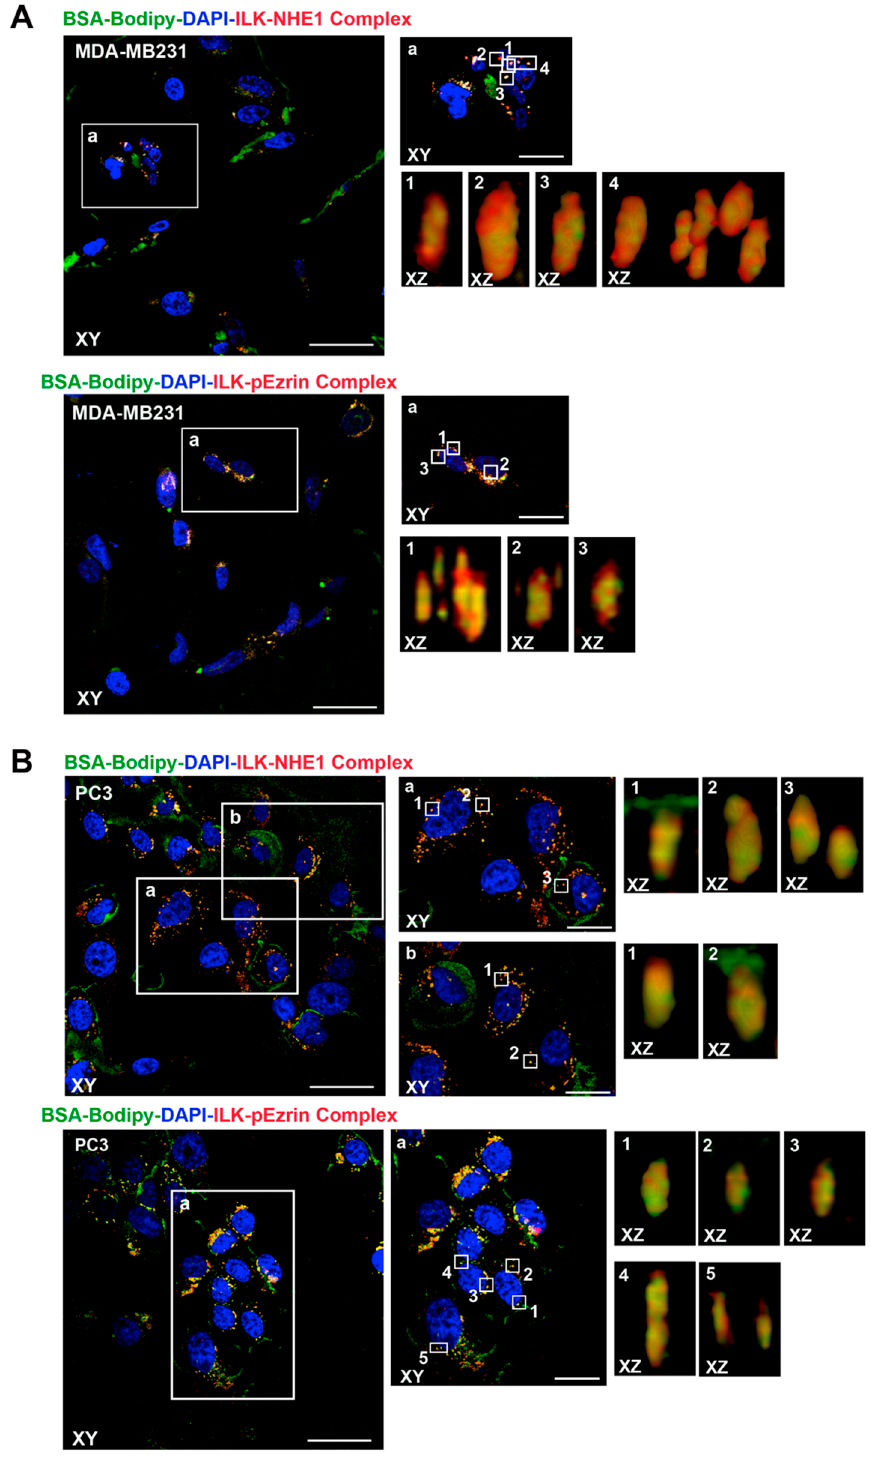
Figure 2. ILK formed protein–protein complexes with NHE1 and p-ezrin within invadopodia in MDA-MB-231 ( A ) and PC-3 ( B ) cells. Cells seeded on Matrigel were allowed to digest the green fluorogenic substrate (DQ) and PLA co-localization assays after fixation. Confocal images in axial planes taken at the bottom of the cells (XY) of a typical region showed protein–protein complexes (red) and digestion (green) localization. In each field, zoomed sections (XZ) reconstructed by alpha blending analysis of the indicated regions of interest (white box) are shown on the right. Importantly, protein–protein complexes (red) and digestion (green) were co-localized in protrusive digestive structures on the ventral cell surface. Scale bars = 10 µm (XY) and 5 µm (XZ).